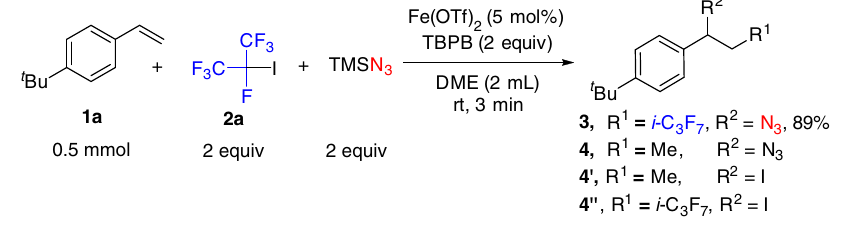
Fig. 2 Optimized conditions for carboazidation of alkenes. Fe(OTf) 2 (5 mol%), 1a (0.5 mmol), 2a (1.0 mmol), TMSN 3 (1.0 mmol), TBPB (1.0 mmol) in DME (2 mL) at rt for 3 min under an N 2